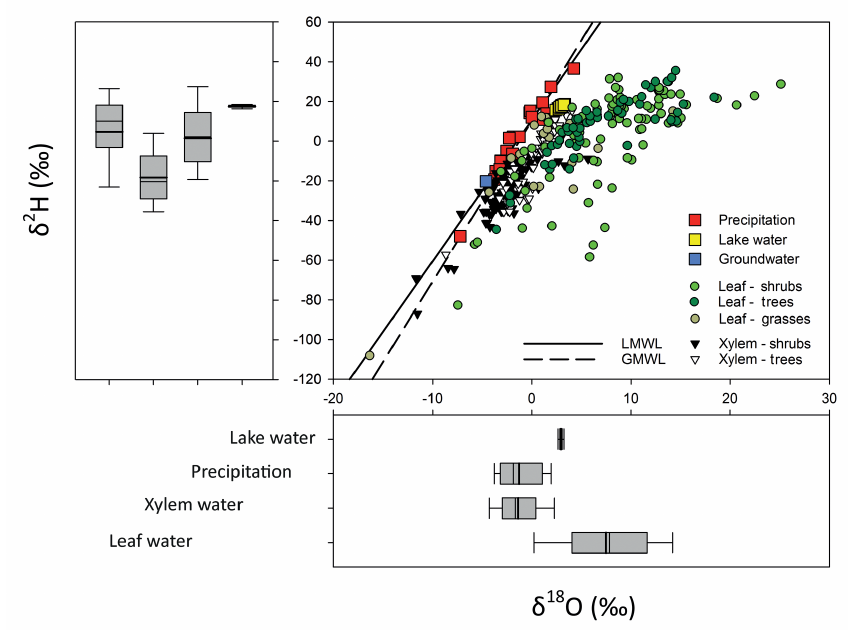
Figure 3. Xylem and leaf water δ 2 H and δ 18 O values of all plant species, seasons and plant habitats in the vicinity of Lake Chala, and lake, precipitation and groundwater against the LMWL ( δ 2 H = 7.12* δ 18 O + 10.69‰, black line). The box plots show the mean (bold line), minimum, first quartile, median, third quartile and maximum for the isotopic composition of leaf water, xylem water, precipitation and lake water. LMWL: local meteoric water line; GMWL: global meteoric water line ( δ 2 H = 8.1* δ 18 O + 10.3‰; Rozanski et al., 1993).